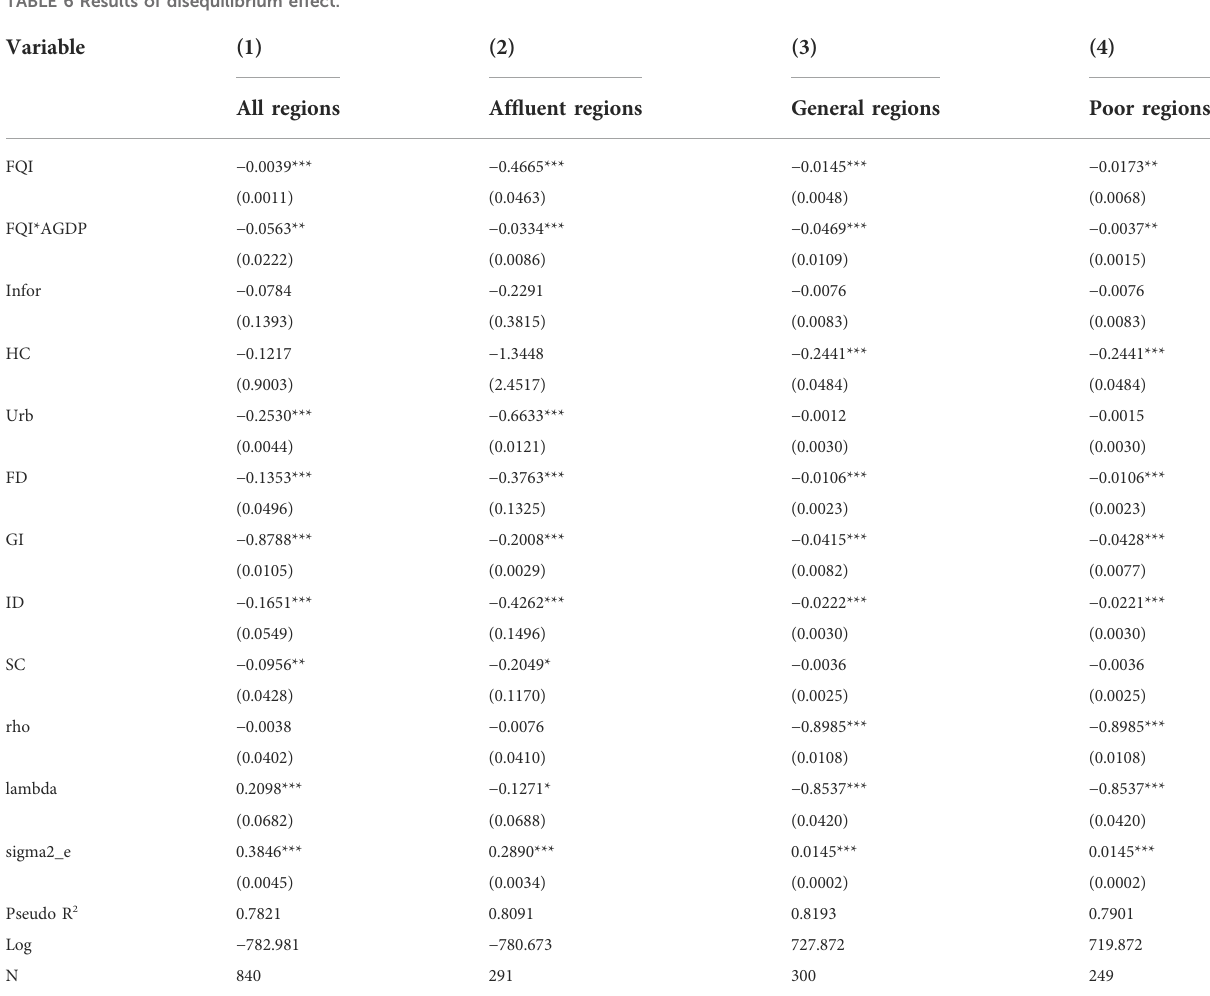
TABLE 6 Results of disequilibrium effect.